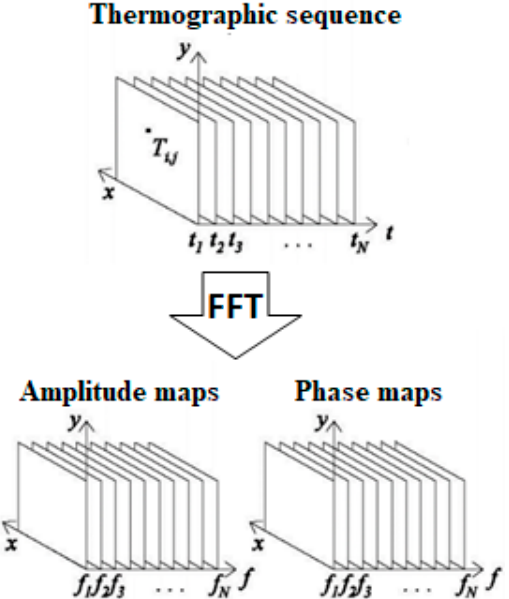
Figure 1. Data acquisition and processing by Pulsed Phase Thermography (PPT).